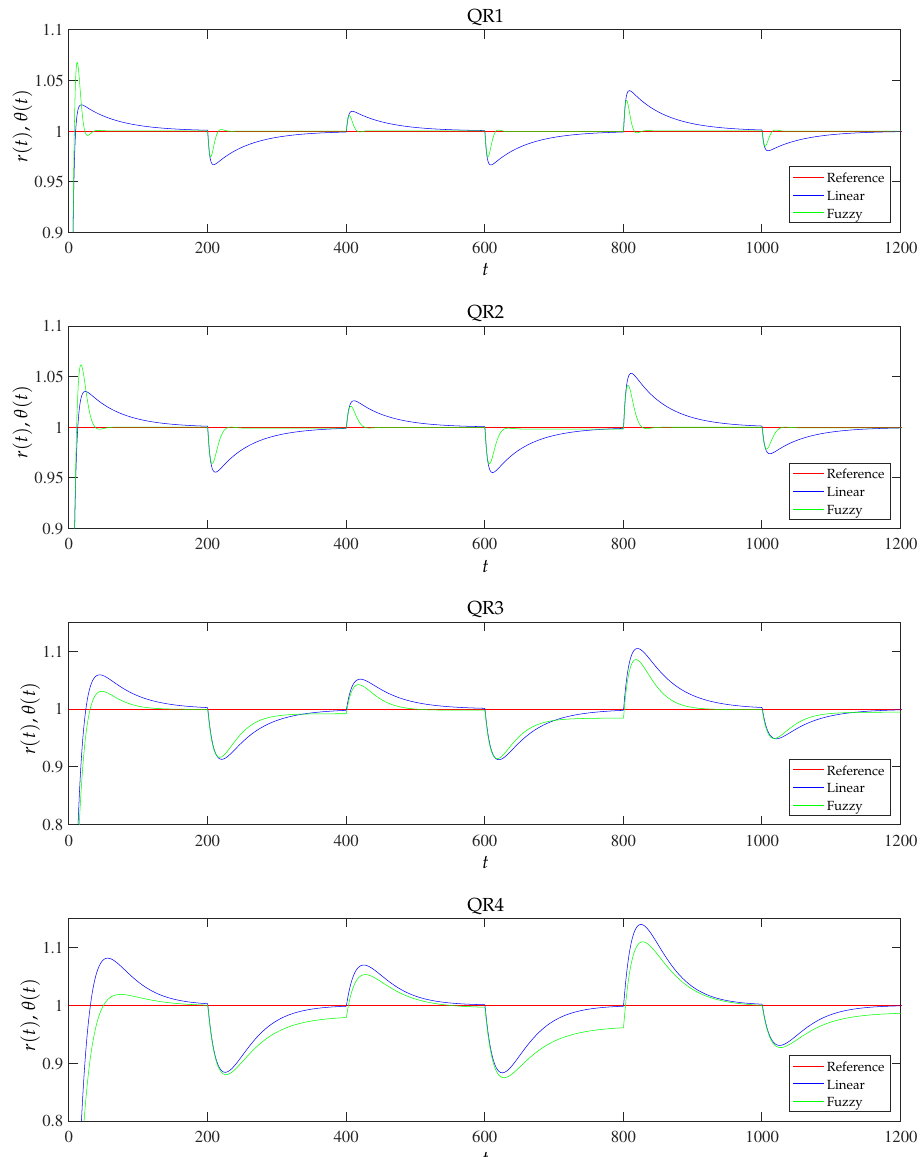
Figure 21. Comparison for the response of the system using linear and fuzzy controllers for different disturbance